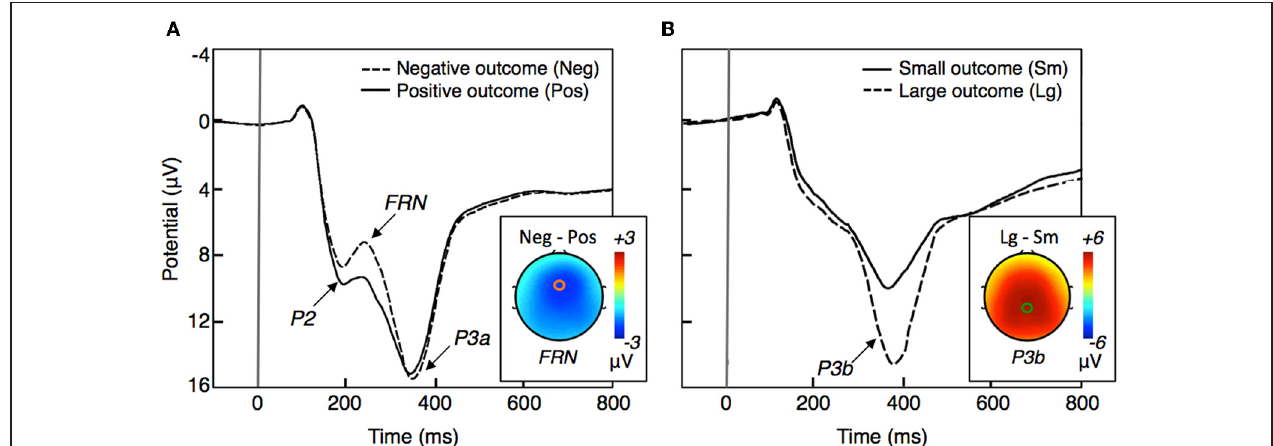
FIGURE 1 | A schematic representation of ERP waveforms typically elicited by outcomes (based on Gehring and Willoughby, 2002; Yeung and Sanfey, 2004; Goyer et al., 2008; Gu et al., 2011a). The horizontal axis represents the elapsed time relative to the onset of behavioral feedback (at 0ms). (A) Example of ERP waveform for negative and positive outcomes recorded at a frontocentral electrode